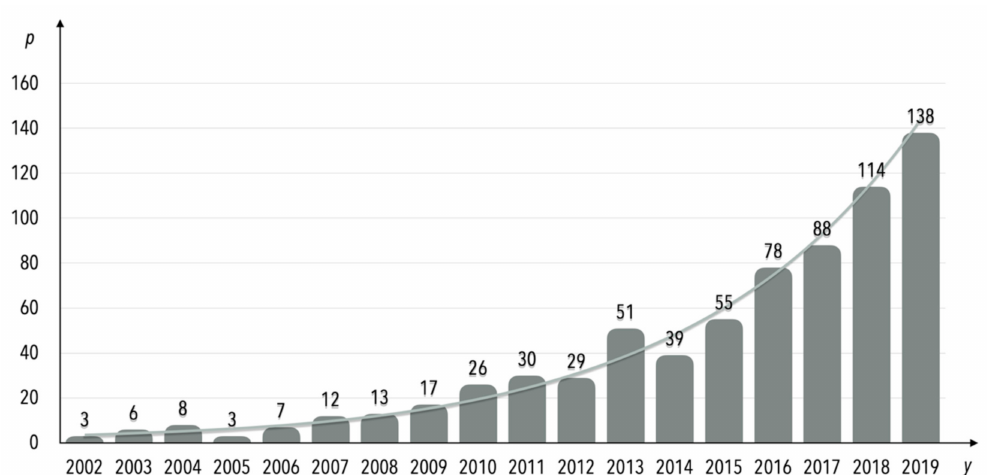
Figure 2. Evolution of publications on sustainable business models literature, 2002–2020 ( n = 776). Source: own elaboration based on Scopus